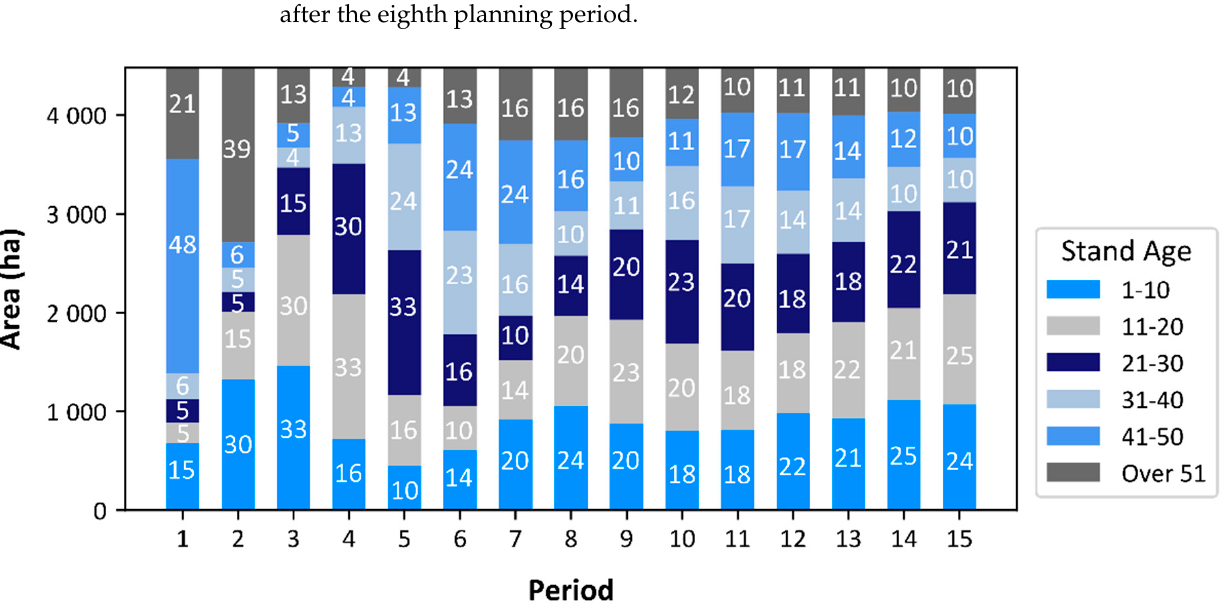
Figure 13. Changes in the tree species composition from the 1st to 15th periods with a 30% timber production variation rate. The numbers in the bar graph indicate the area proportions of each spe- cies in the period. Strategic broad-leaved trees denote the species specifically planned to expand